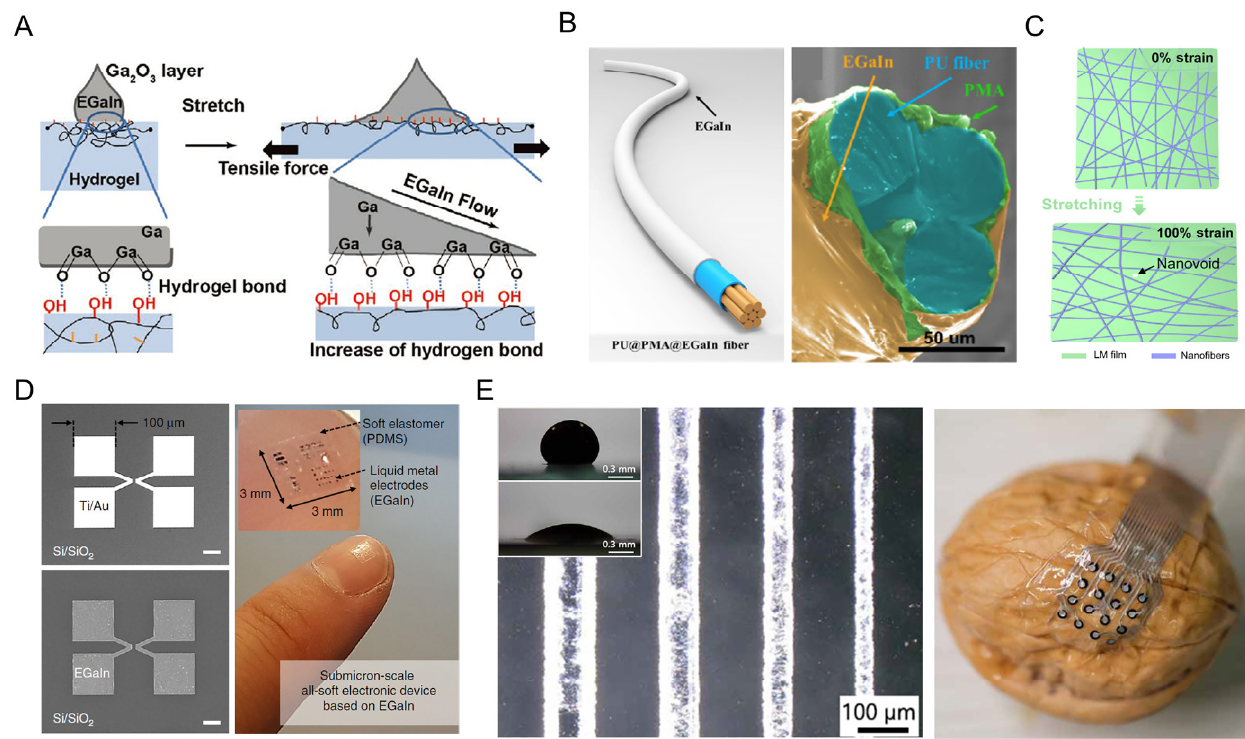
Figure 8. Enhancement strategies for LM–elastomer interfaces. ( A ) Schematic of the interactions be- tween Ga2O3 layer with -OH groups on hydrogel upon stretching [91]. Copyright: (2020) Wiley-VCH. ( B ) Schematic and cross-section SEM of PPE fiber coated with PMA and LM [96]. Copyright: (2020) American Chemical Society. ( C ) Schematic of LM-nanofiber scaffold interface under stretching [74]. Copyright: (2022) Wiley-VCH. ( D ) Micro-morphologies of patterned Au ( left top ) and EGaIn on Au ( left bottom ). Scale bar: 40 µm. The encapsulation of the EGaIn structures on a fingertip [94]. Copyright: (2020) Springer Nature. ( E ) Optical microscopy images of the LM line array ( left ) with contact angle images of the LM on SEBS and copper ( left inset ), and digital photography of the conformal attachment of an LM-based electrode array [95]. Copyright: (2022) AAAS.